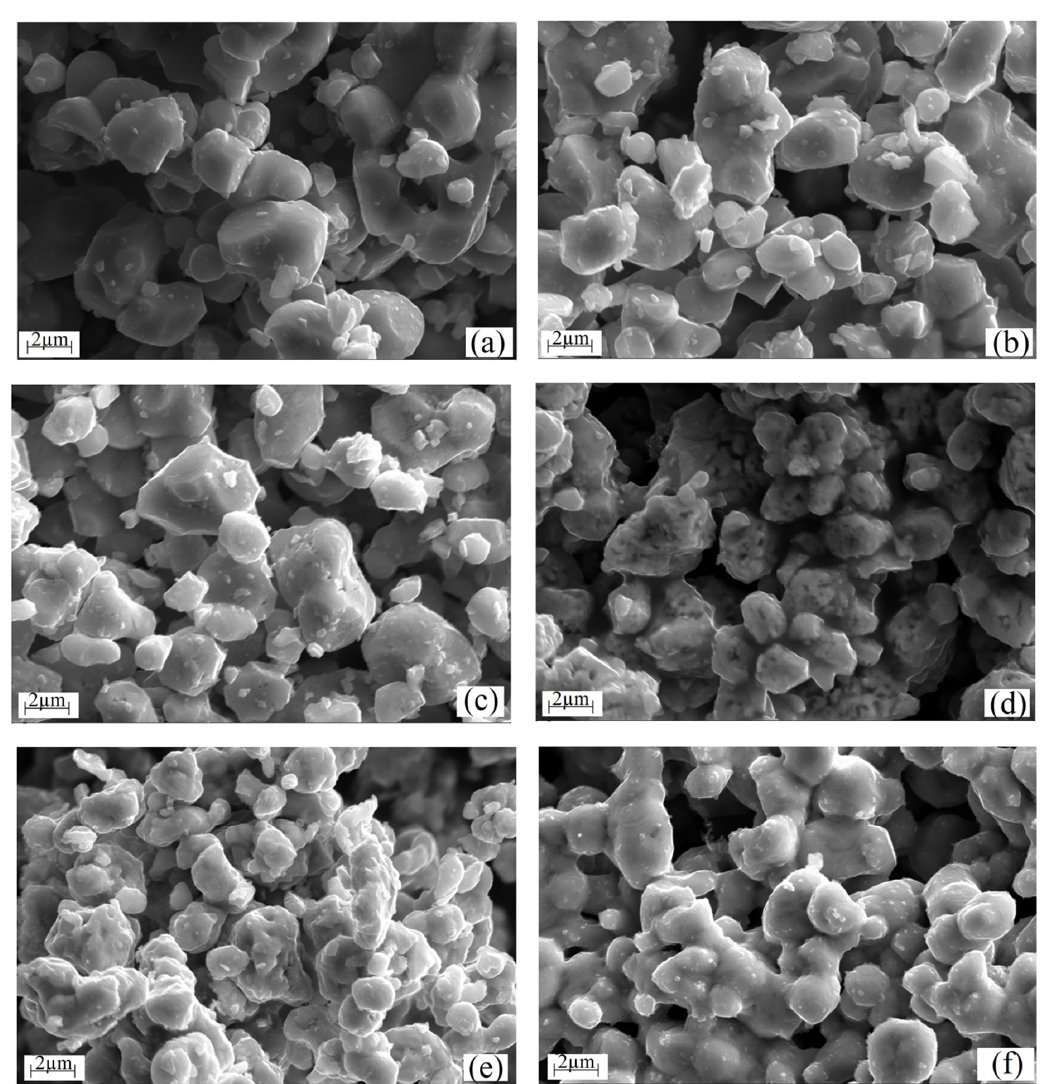
Figure 3. Scanning Electron Microscope photographs of pure hematite samples before reduction ( a ) and after reduction in pure hydrogen at a heating rate of 20 °C/min from room temperature to ( b ) 445 °C, ( c ) 490 °C, ( d ) 505 °C, ( e ) 510 °C, and ( f ) 600 °C.